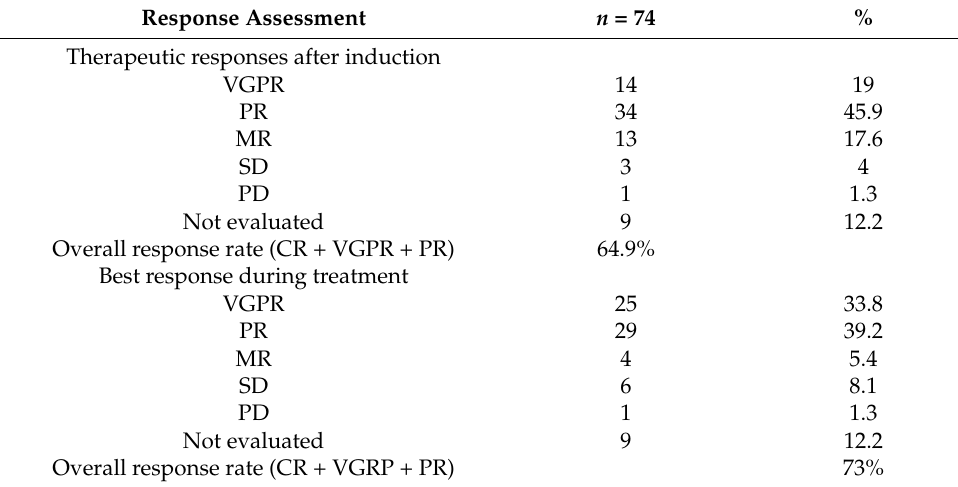
Table 2. Response rate of the study cohort.